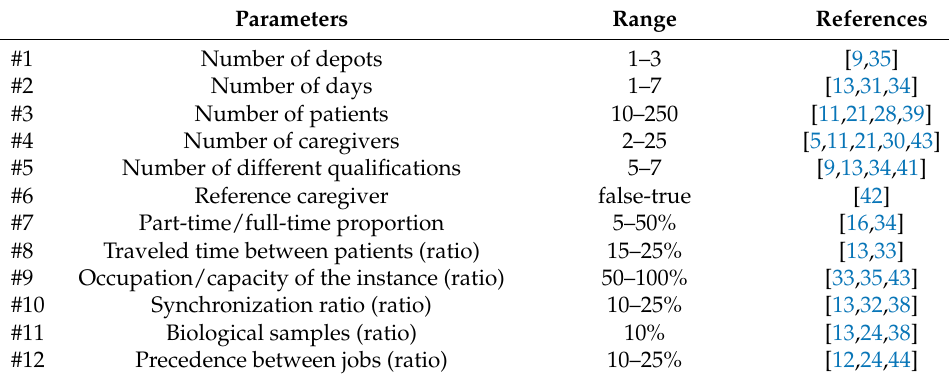
Table 4. Range of all editable